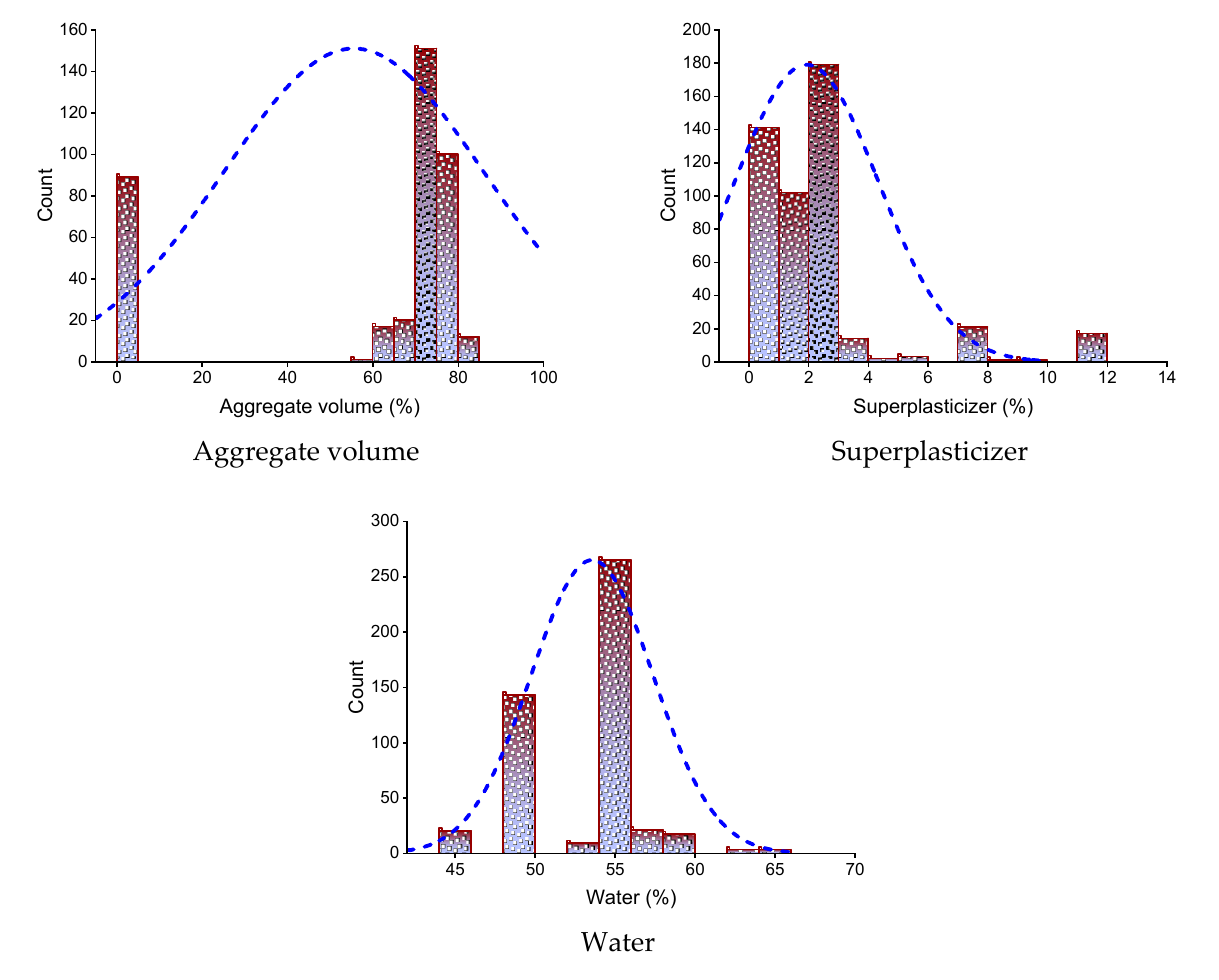
Figure 1. Relative frequency dispersal of inputs parameters.